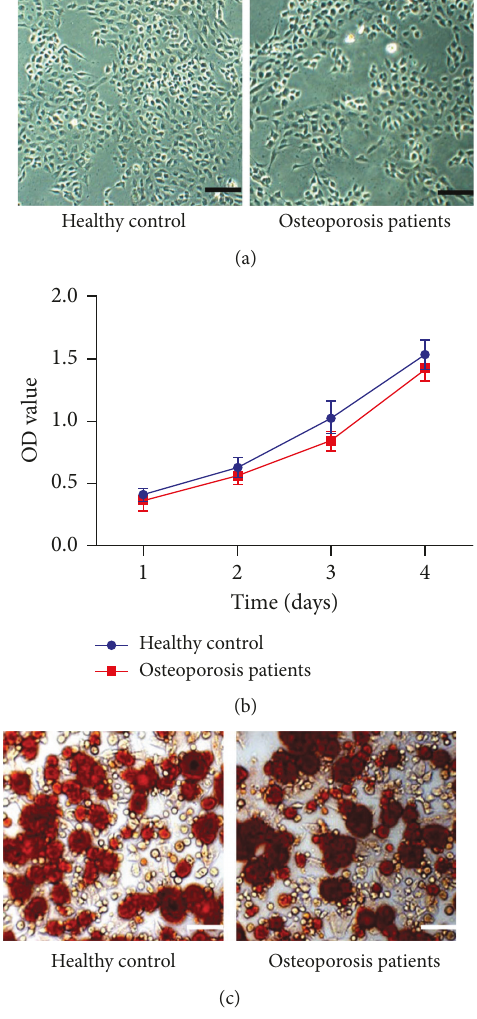
Figure 1: The ASCs derived from the patients with osteoporosis mainly had round-up or spindle-shaped morphology, which were similar to the ASCs from healthy donors (a). MTT assay and alizarin red S staining showed that ASCs derived from the osteoporosis patients had similar proliferation and osteogenic di ff erentiation capacity with those from healthy controls (b,